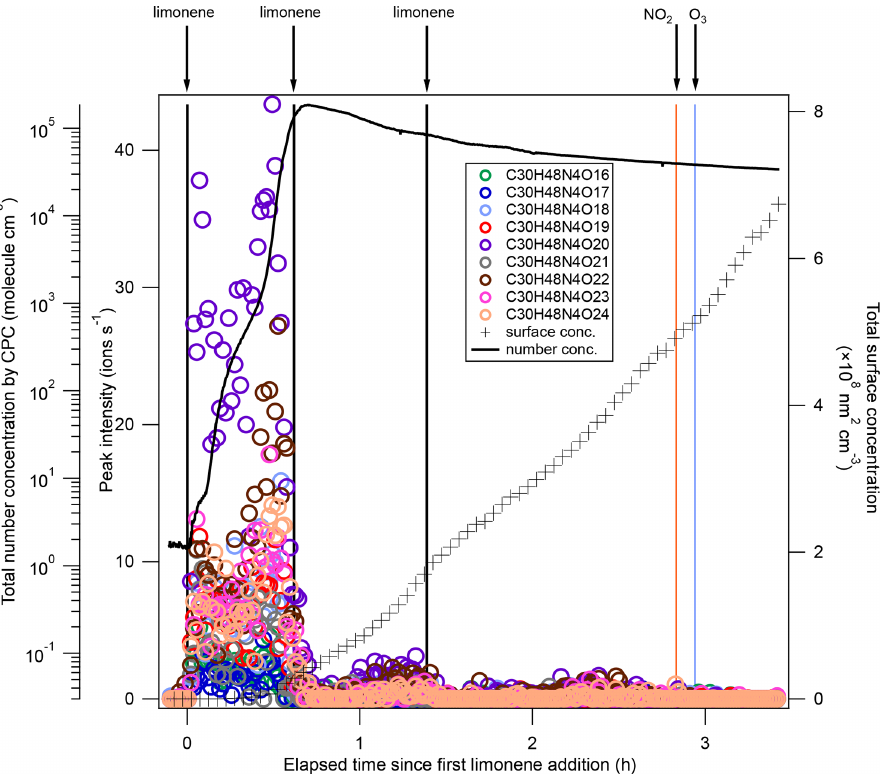
Figure 6. Time series of peak intensity of the C 30 H 48 N 4 O x family compounds during the periods P1 to P3. The solid black line refers to total number concentrations detected by CPC. The cross markers (right y axis) indicate total particle surface